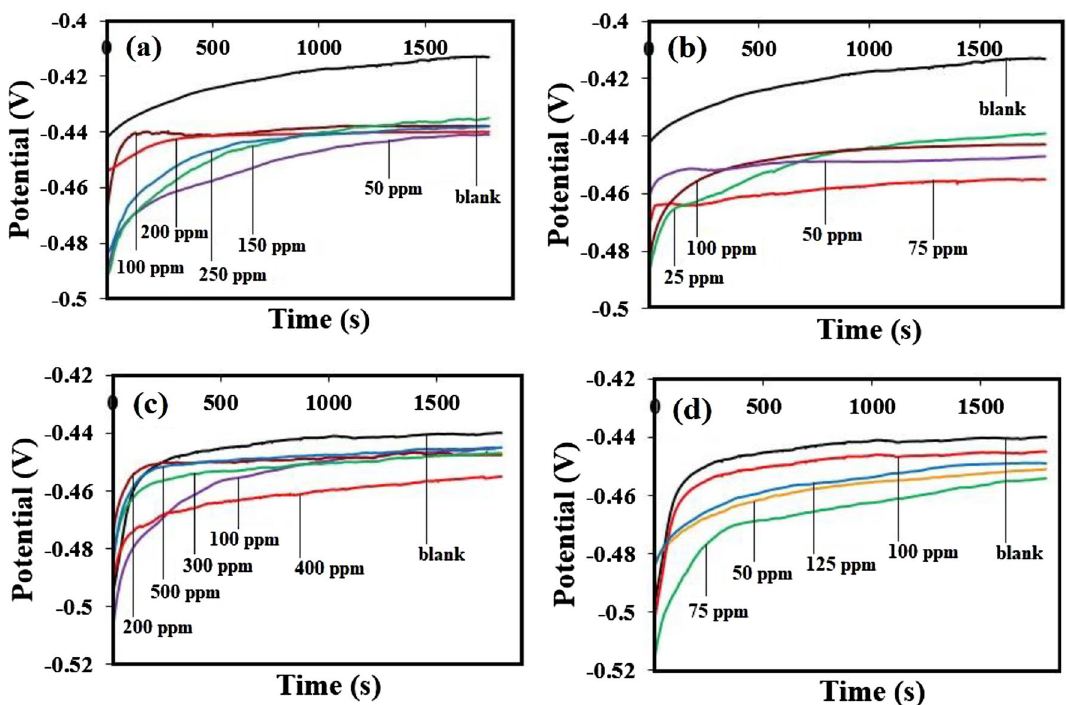
Figure 2. Variation of the OCP as a function of time, recorded for st-37 in 0.5 M H 2 SO 4 ( a ) based on bulk, and ( b ) nano size of Dracocephalum , and in 1.0 M HCl ( c ) based on bulk, and ( d ) nano size of Dracocephalum , at 25 ± 1